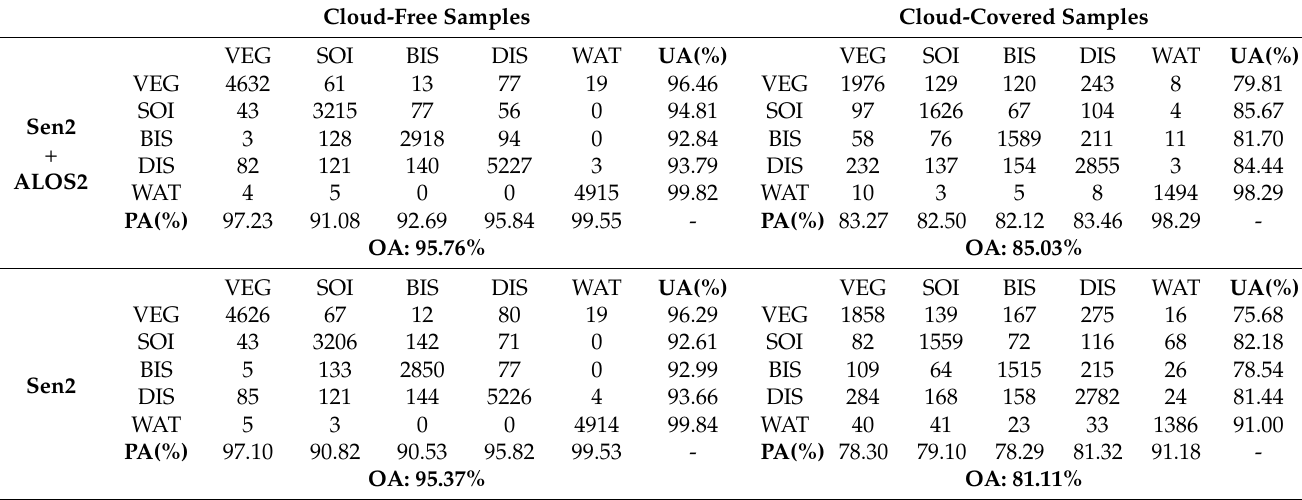
Table 1. The confusion matrix of cloud-free samples and cloud-covered samples with single optical data and combined optical and SAR data. Columns represent classification labels, and rows represent the actual labels of the testing data. Cloud-Free Samples